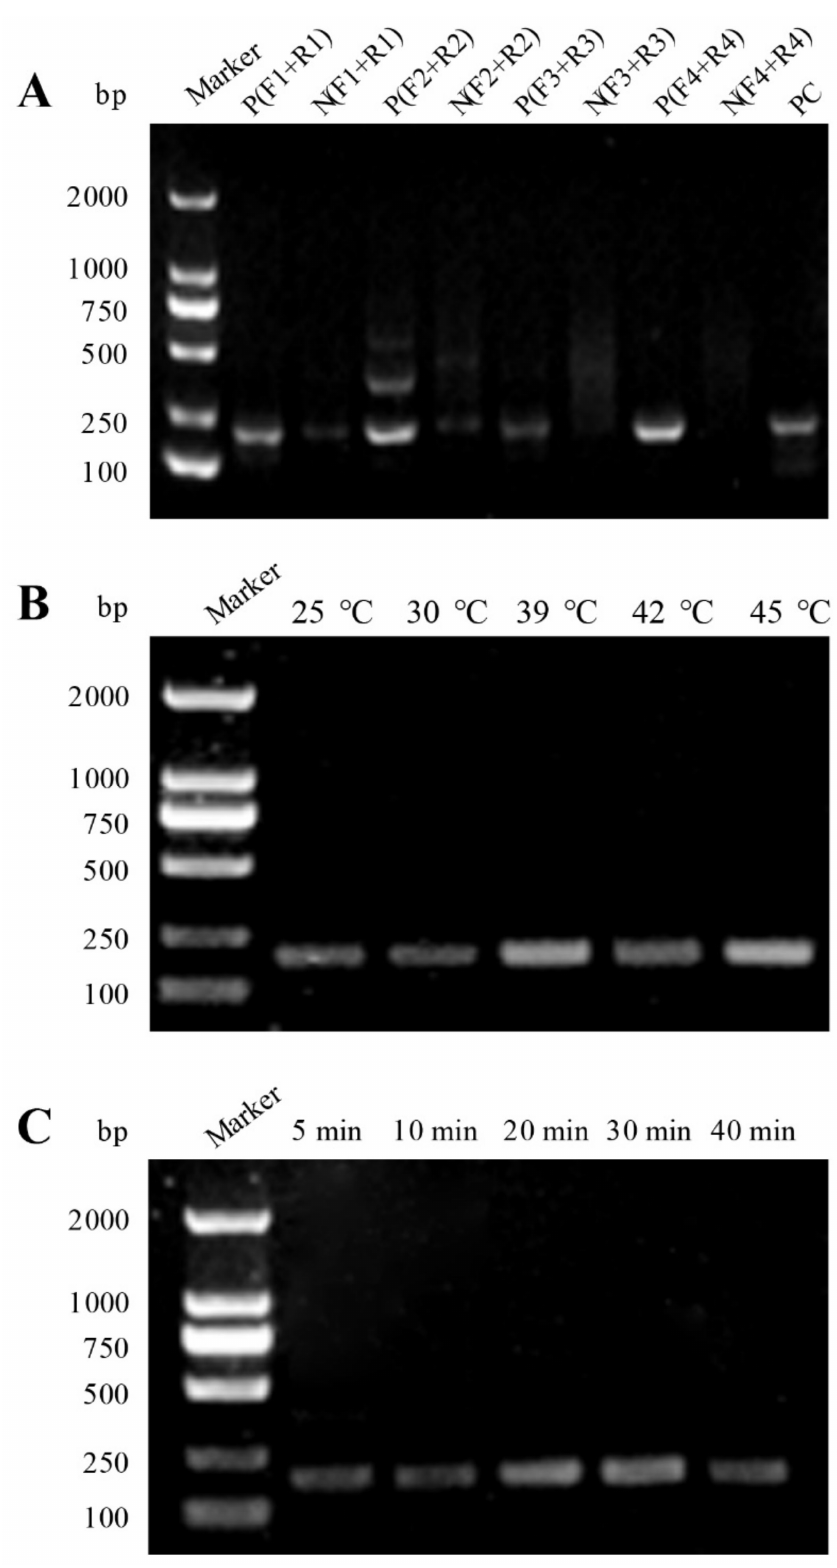
Figure 2. Optimization of the RAA assay. ( A ) Screening of the RAA primers. Agarose gel elec- trophoresis of RAA amplification products using different primer combinations. ( B ) Optimization of reaction temperature of the RAA assay. ( C ) Optimization of reaction time of the RAA